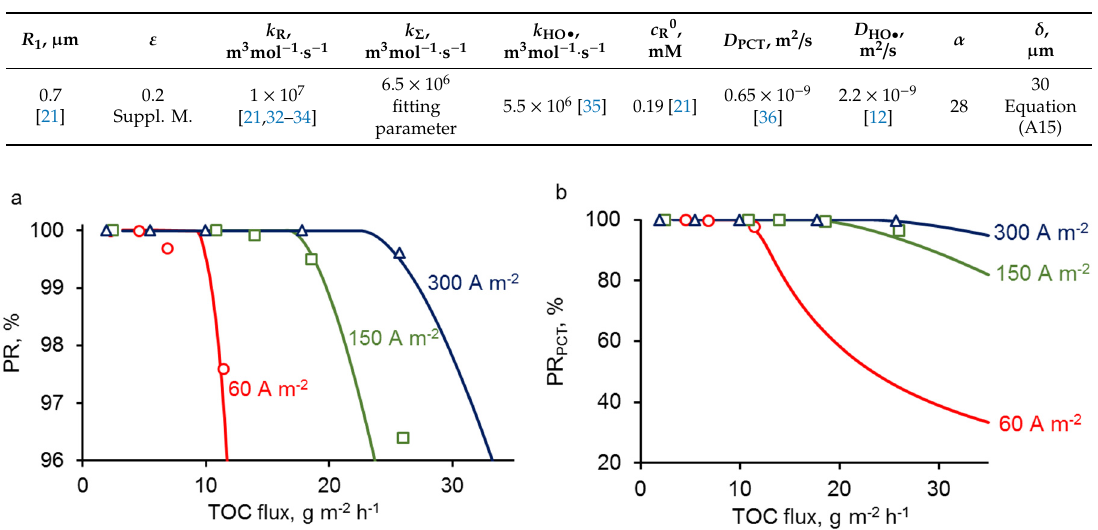
Table 1. Parameters of the system used in the simulations. PCT: paracetamol.